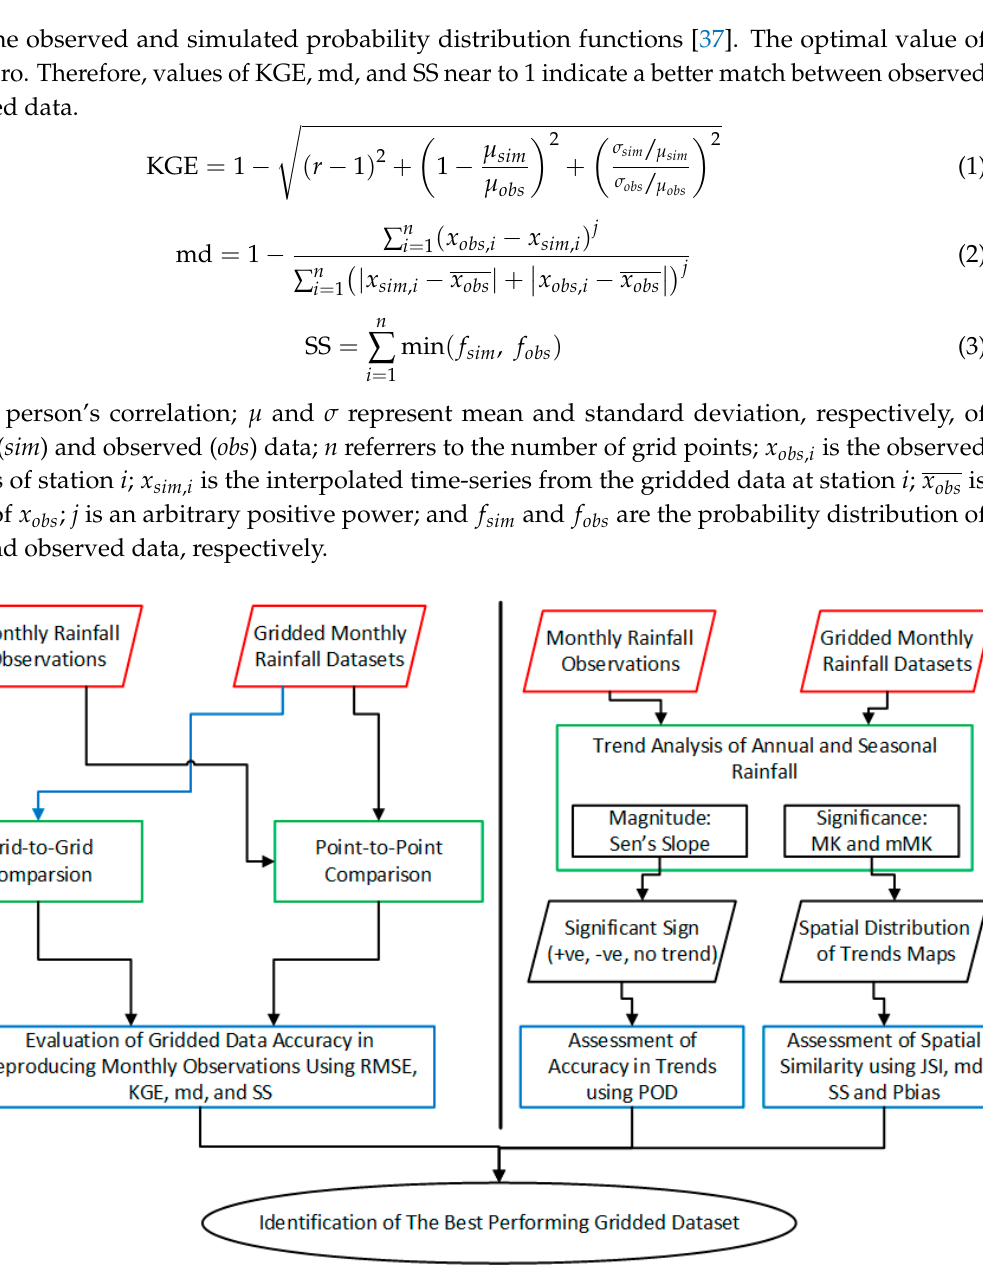
Figure 3. Flowchart of the methodology used in this study.